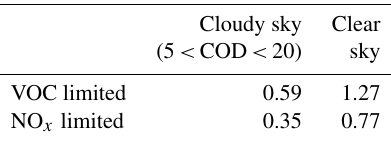
Table 3. Sensitivity coefficient of O 3 to J NO 2 , i.e., dln(O 3 )/ dln( J NO 2 ). The values of dln(O 3 )/ dln( J NO 2 ) for the period of 09:00–13:00LST are averages over only the CONUS EPA stations that have monotonically increasing O 3 concentrations with time.